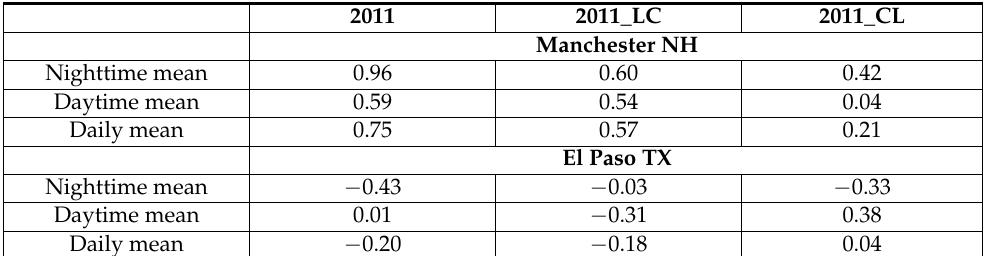
Table 1. Change from 2001 in surface temperature ( ◦ C) for the 3